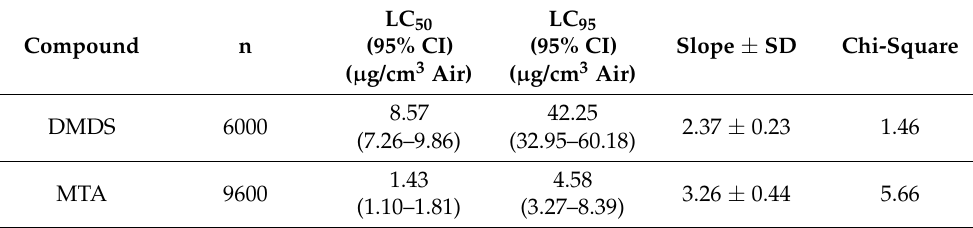
Table 1. LC 50 and LC 95 of DMDS and MTA against C. elegans for 24 h fumigation